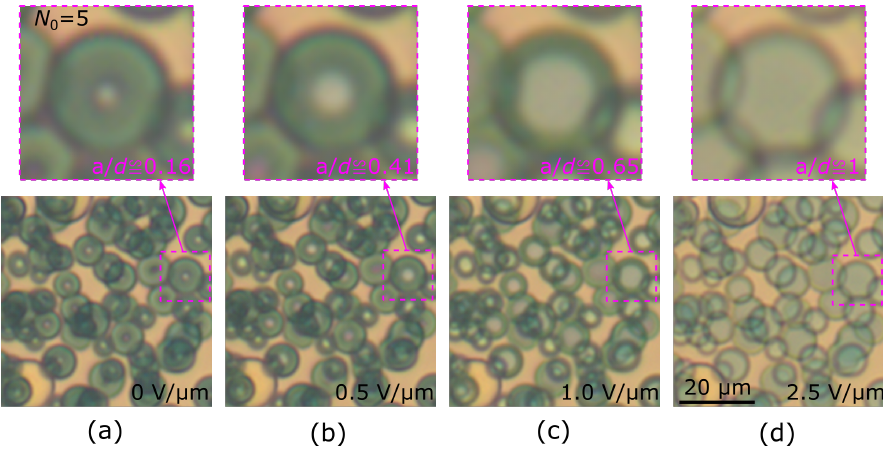
Figure 6. Optical images of the cholesteric droplets taken in non-polarized light. Electric field E equals to 0 V/ µ m ( a ), 0.5 V/ µ m ( b ), 1.0 V/ µ m ( c ), and 2.5 V/ µ m ( d ). The insets show the droplet with N 0 = 5. Intrinsic helix pitch is p 0 = 4 µ m. The scale remains the same in all images in a